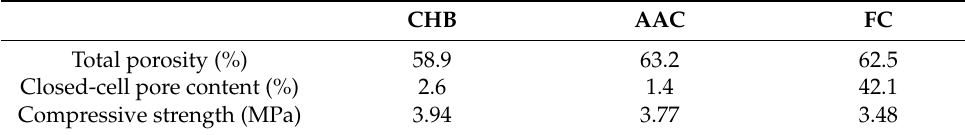
Table 1. Pore structure properties of the three types of porous concrete. CHB AAC Total porosity